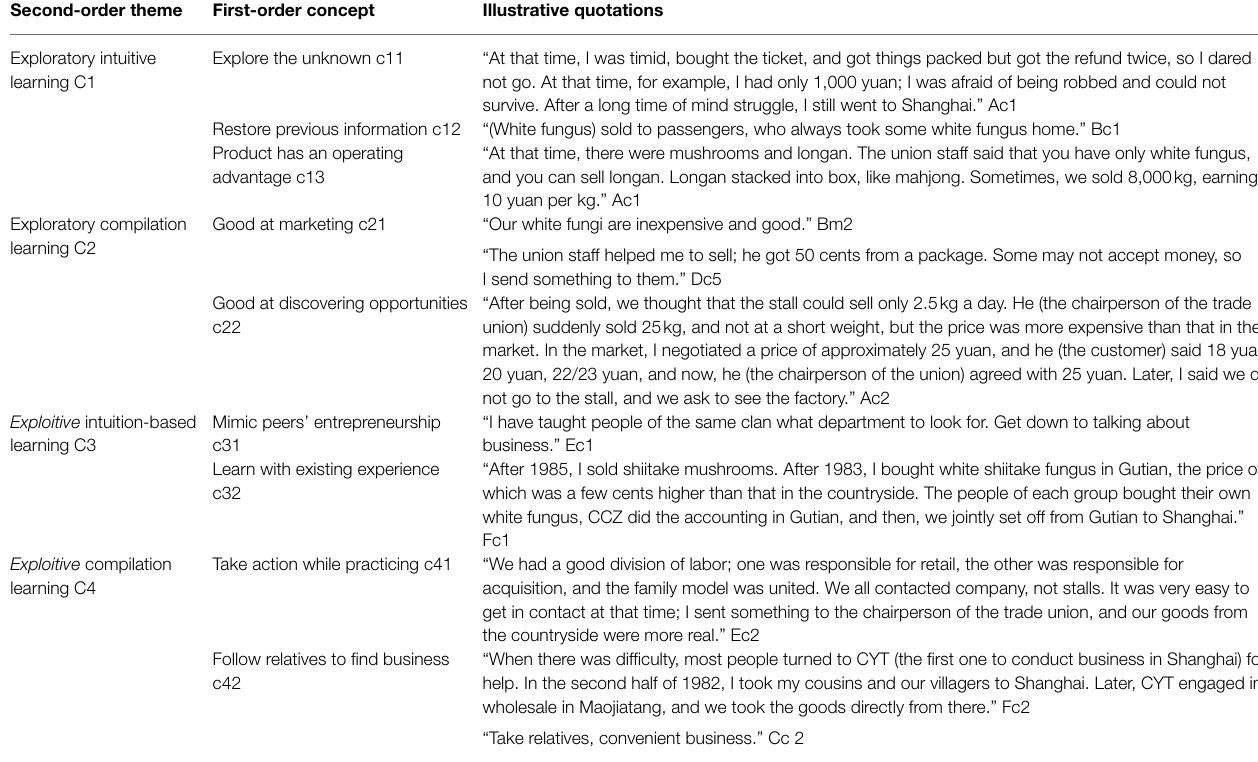
TABLE 4 | Illustrative quotations of first-order concepts in the “crossroads”